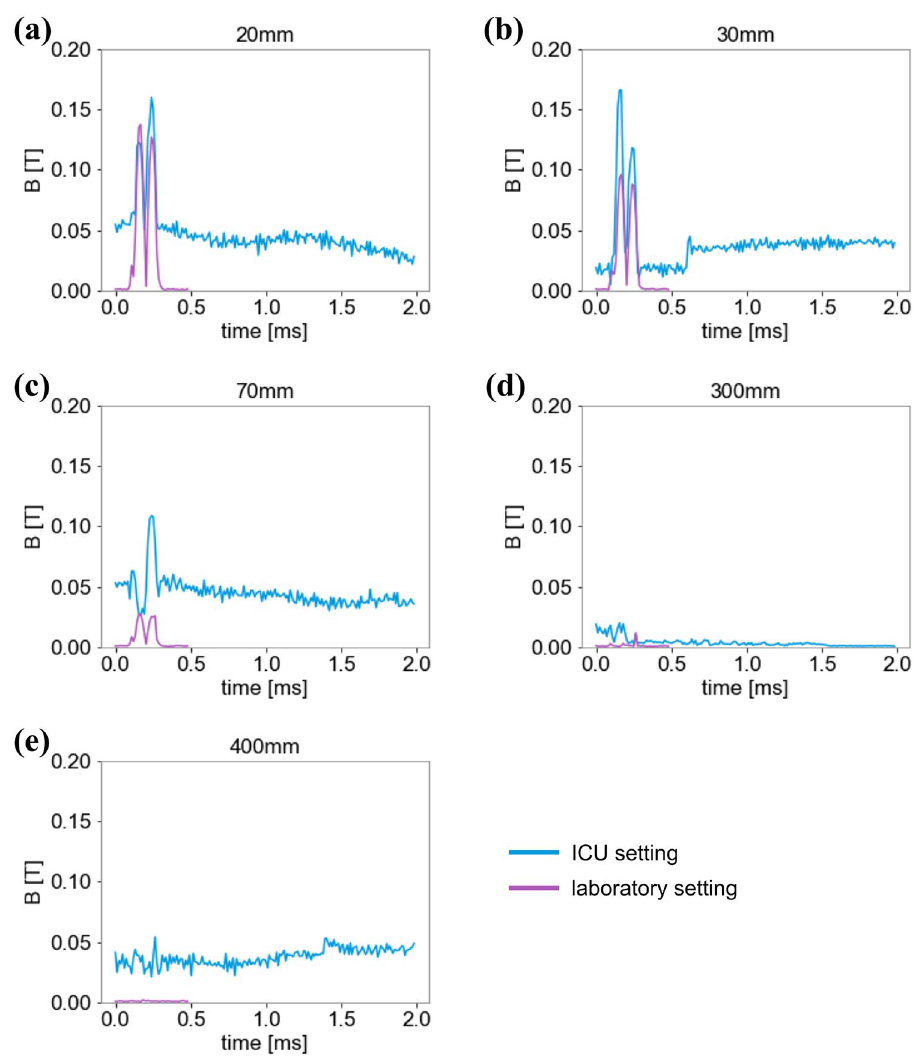
Figure 1. Magnetic flux density at different distances vertical to the coil. Measurements at different distances to the stimulation coil were done. At 300 mm and 400 mm a lot of artefacts occurred and no clear signal was detectable. Results in the ICU setting in general show a lot of noise, offset and amplification due to surrounding electronic